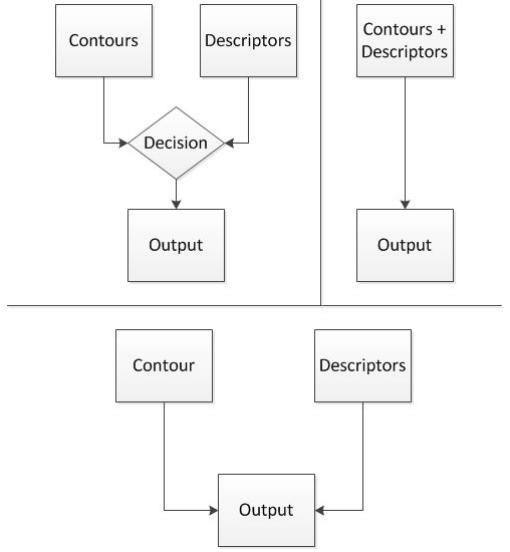
Figure 8. Methods to combine